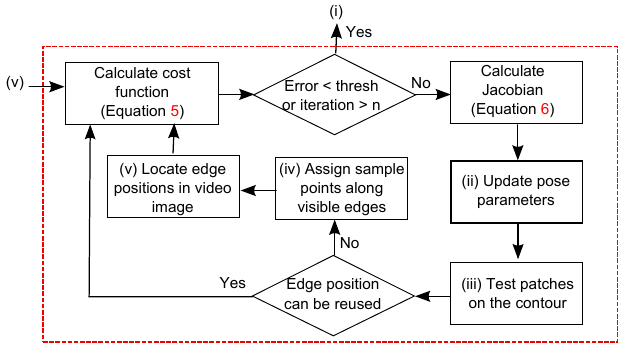
Fig. 4. More details about the operations processed in step (vi): the error value returned by the cost function is evaluated and if it less than the threshold, the pose can be updated. Otherwise, the pose parameters are refined. Since the apparent contour changes according to the viewpoint, the edge positions are tested again to verify if the correspondence between visible edges and detected points have changed. If necessary, steps (iv) and (v) are repeated.